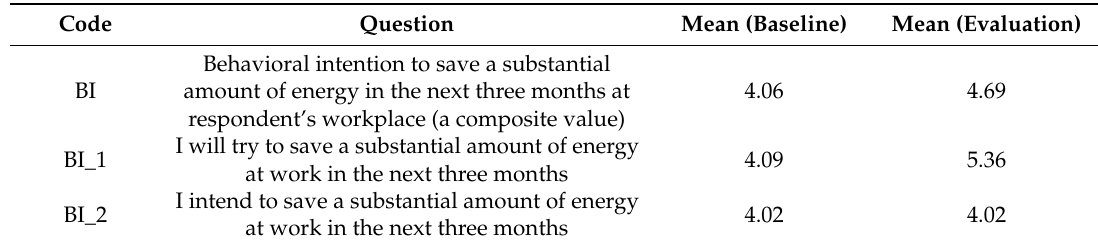
Table 12. Mean score for factors related to behavioral intentions (BI) (totally disagree (1) to completely agree (7)).